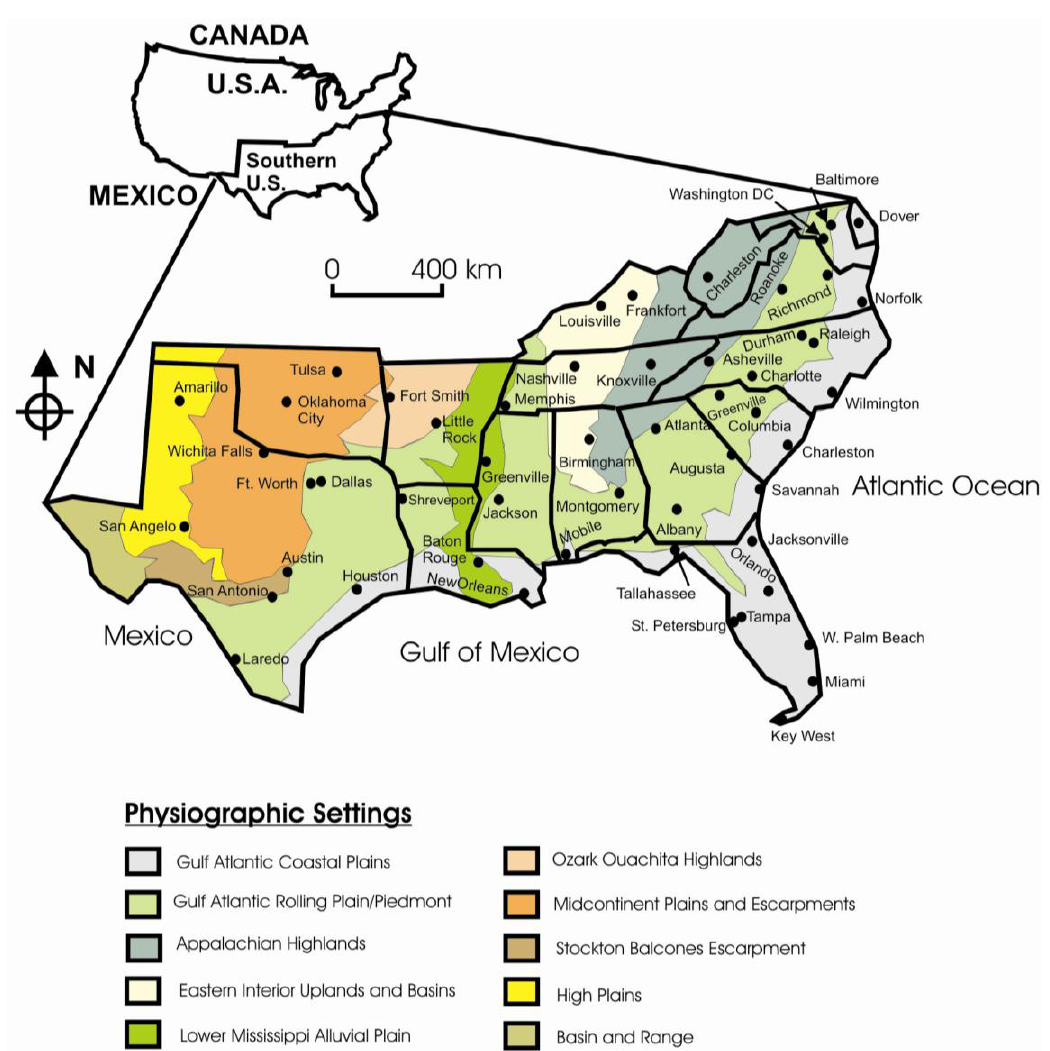
Figure 1. Physiographic settings and major cities of the southern U.S. (modified from Hammond, 1970)